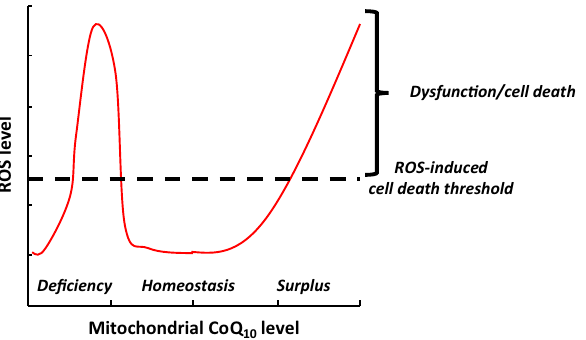
Figure 8. Relationship between mitochondrial CoQ 10 level, reactive oxygen species (ROS) level, and ROS- induced cell death threshold. Both CoQ 10 deficiency 22 and CoQ 10 surplus increase ROS levels, resulting in mitochondrial dysfunction and cell death, while homeostatic levels of CoQ 10 support cellular function and survival. The ROS-induced cell death threshold likely differs between cell